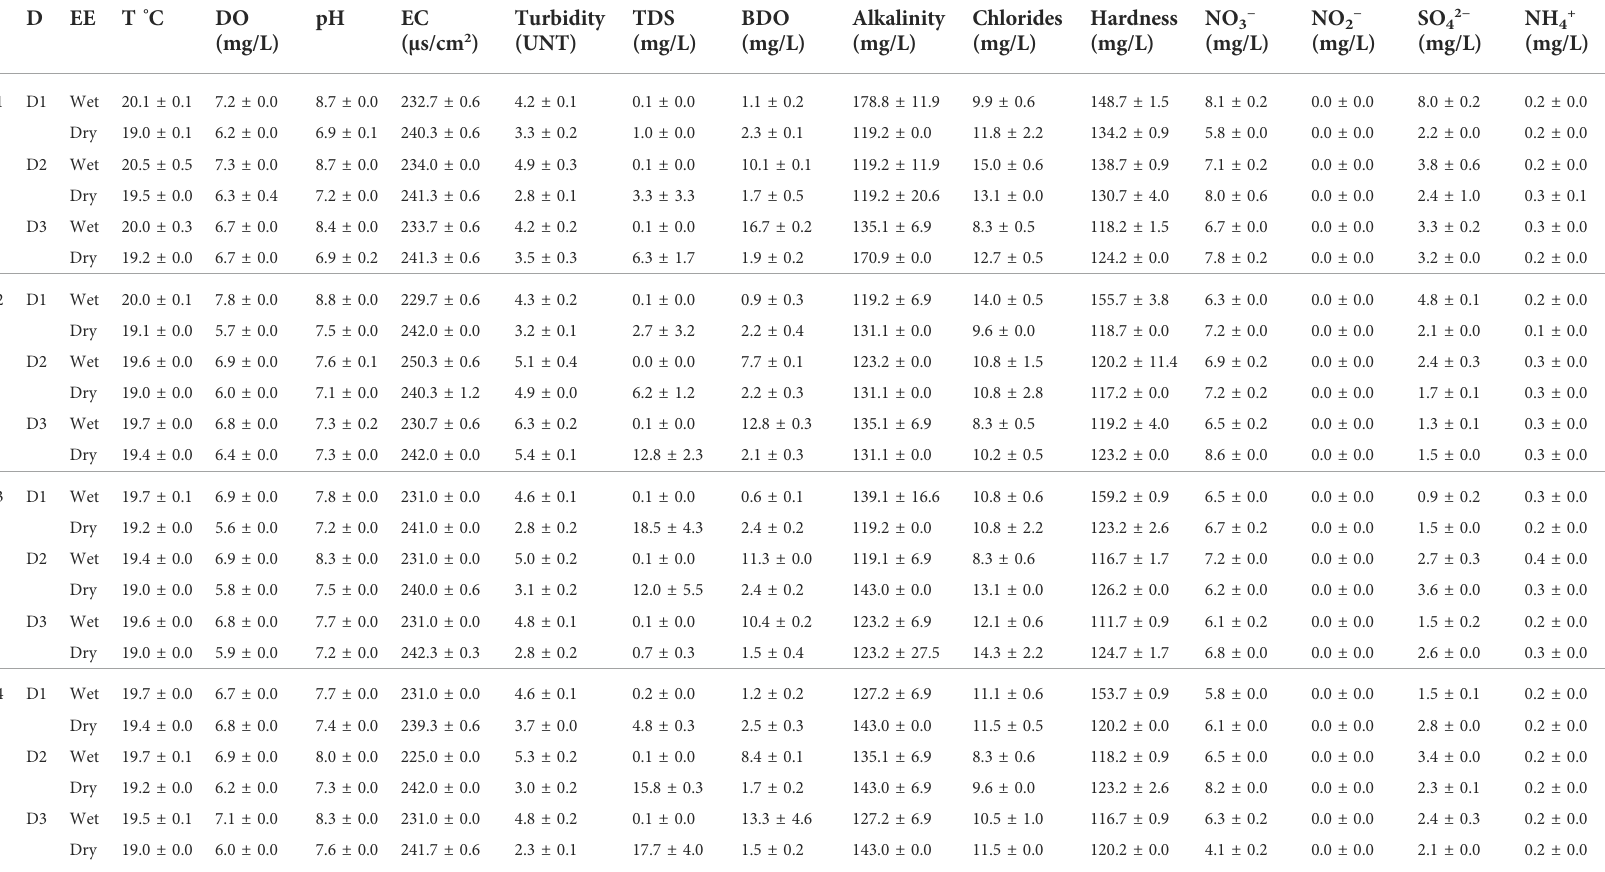
TABLE 1 Mean concentration and standard deviation of physicochemical parameters of the water pro fi le.